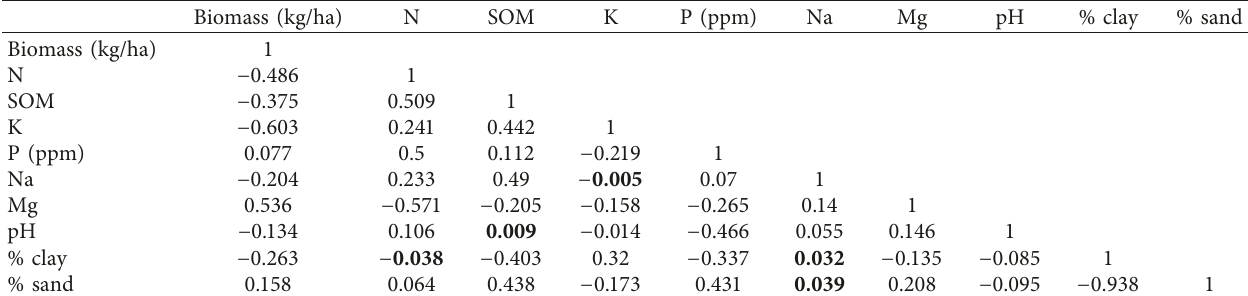
Figure 3: Shows wilting point (WP), field capacity (FC), and available water content (AWC) for the different land cover types in Karamoja. Table 2: Relationship between soil properties and forage quantity in